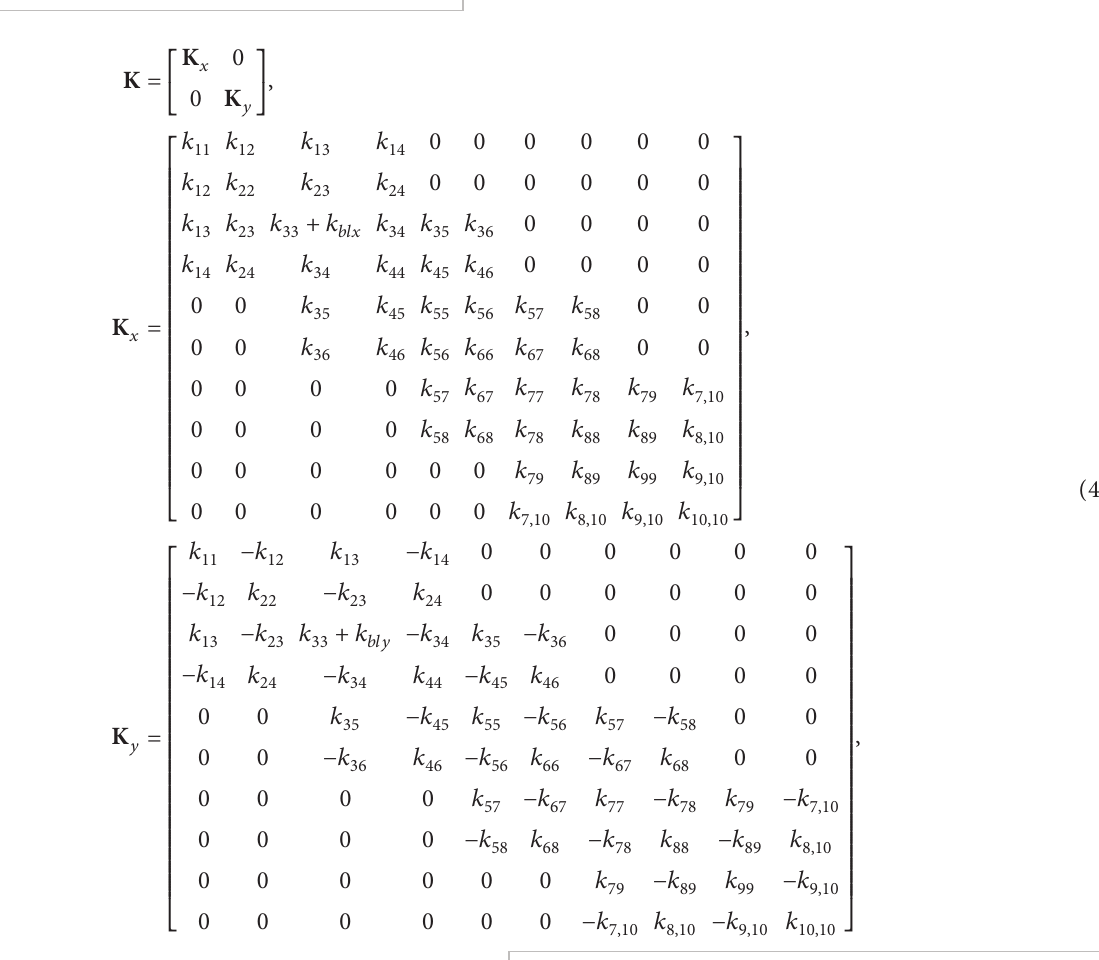
points, respectively. i is the number of lumped mass points.